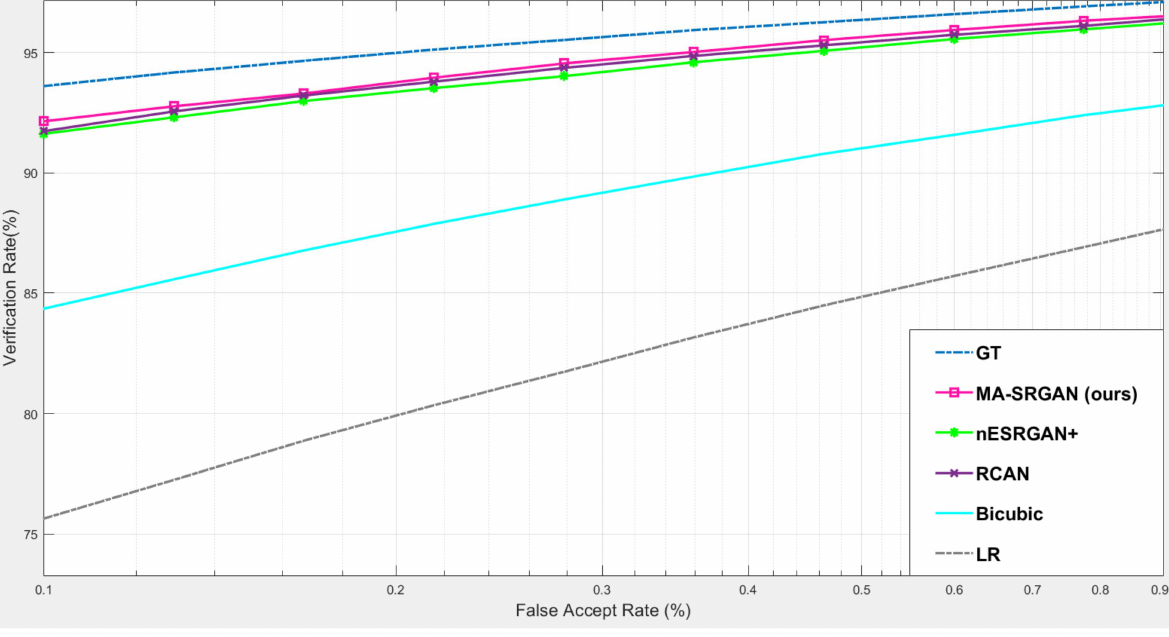
Figure 14. The comparison of ROC curves between nESRGAN+ (current SOTA) and MA-SRGAN (SR/wMsk) on the CASIA